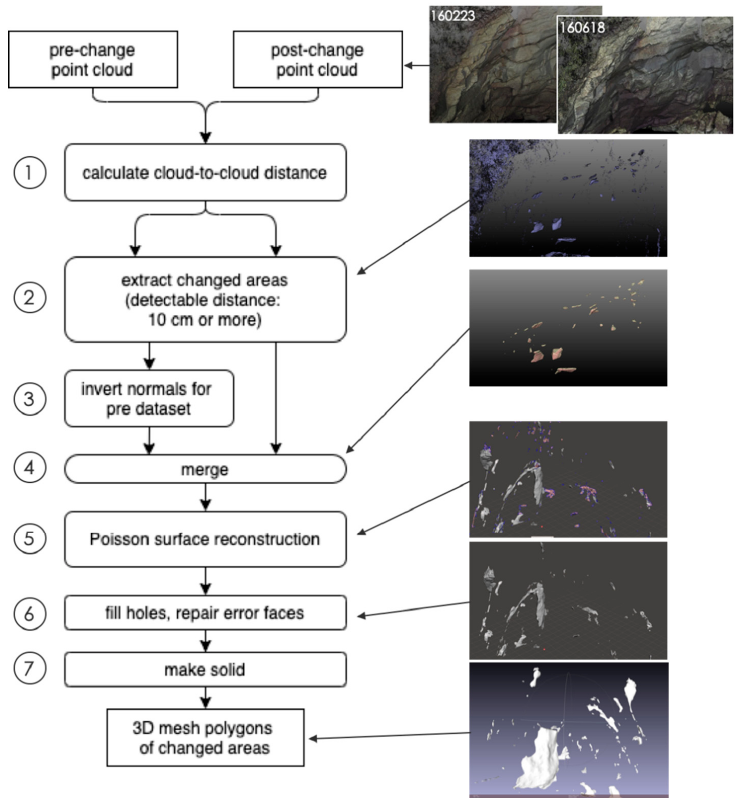
Figure 4. Flow chart of the differential volume estimate (DVE) processing. The differentiation process is given in the left side, while the right-side pictures show the screenshots of the data at some key processes.